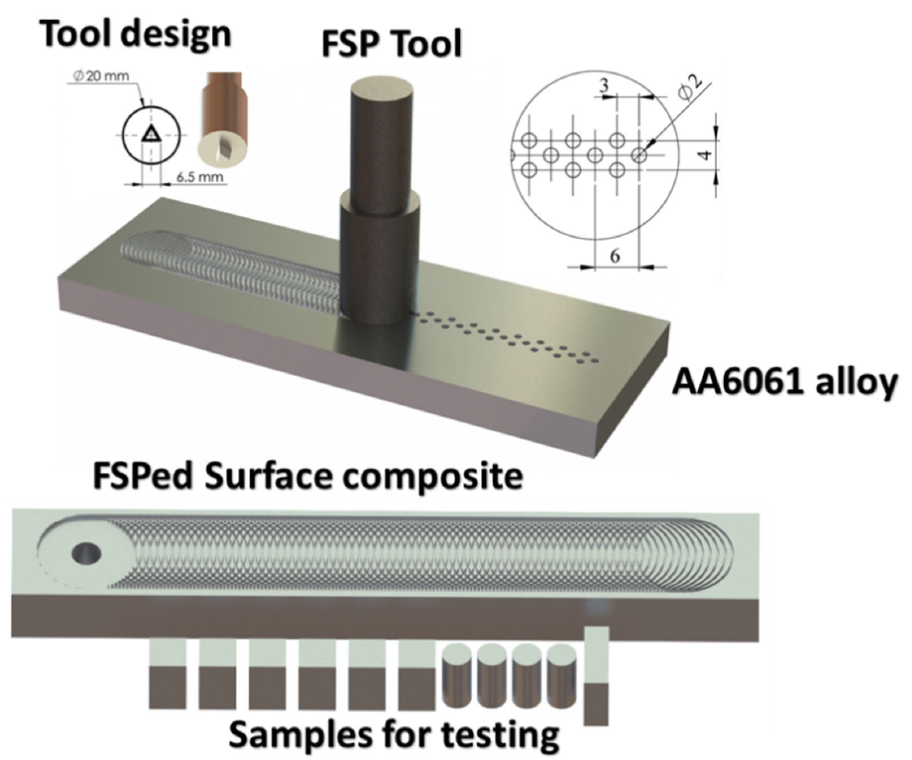
Figure 2. The schematic draw of the FSP process, tool design, and sample location; all dimensions in mm.